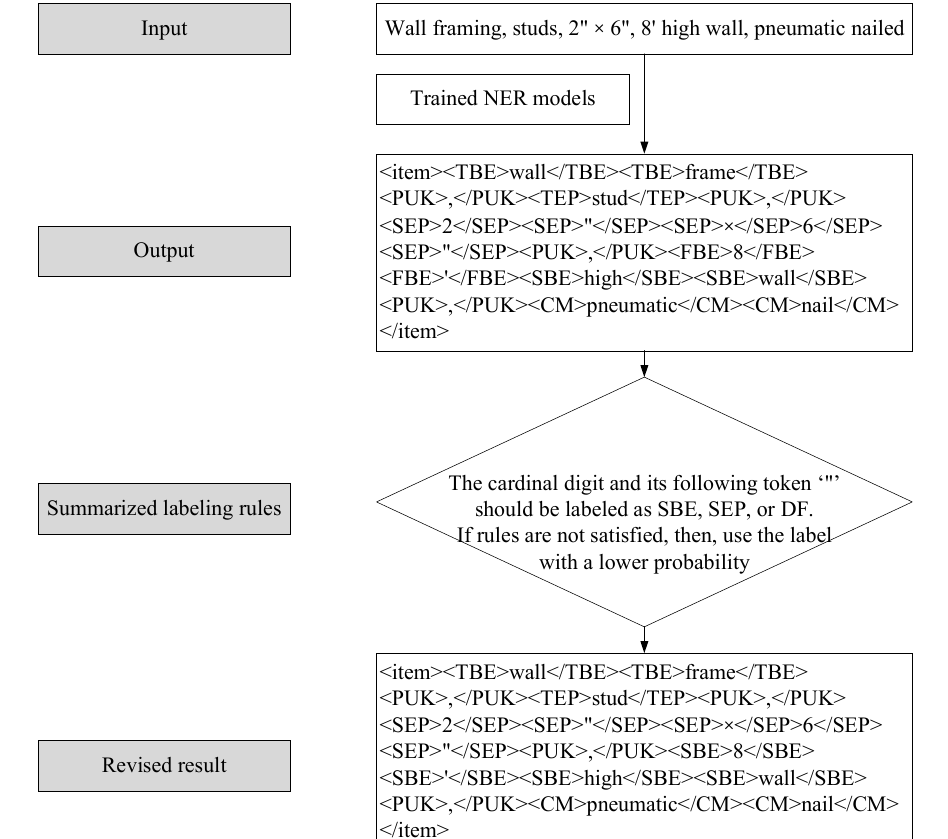
Figure 8. Flowchart and example of sequencing labeling rules with ML-based